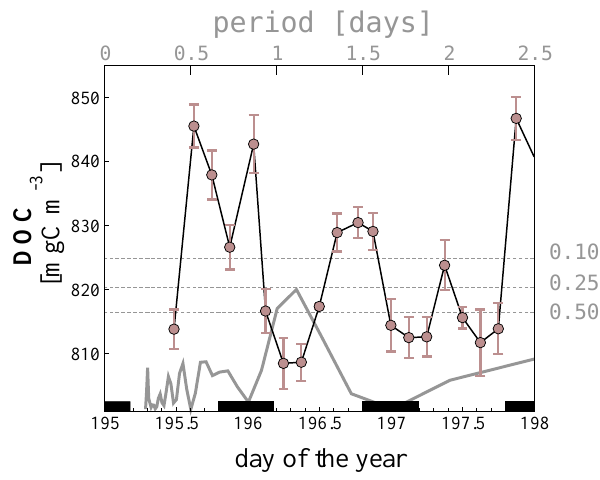
Fig. 8. Time series of dissolved organic carbon concentrations (er- ror bars are standard deviations of duplicates). The solid grey line is the corresponding Lomb-Scargle normalized periodogram plotted as a function of period (upper axis). Horizontal dashed grey lines are three significance levels (0.5, 0.25, 0.1) for the periodogram